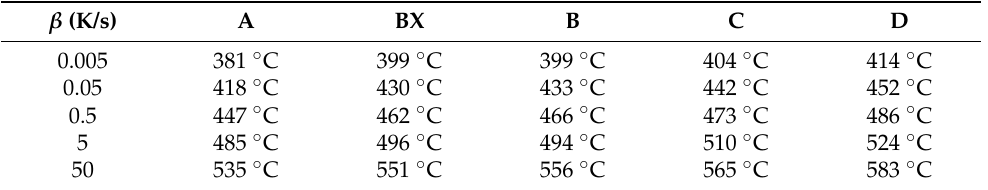
Table 3. Temperatures corresponding to inflection points ( T i ) at different heating rates ( β ) for stage II of tempering in the dilatometry